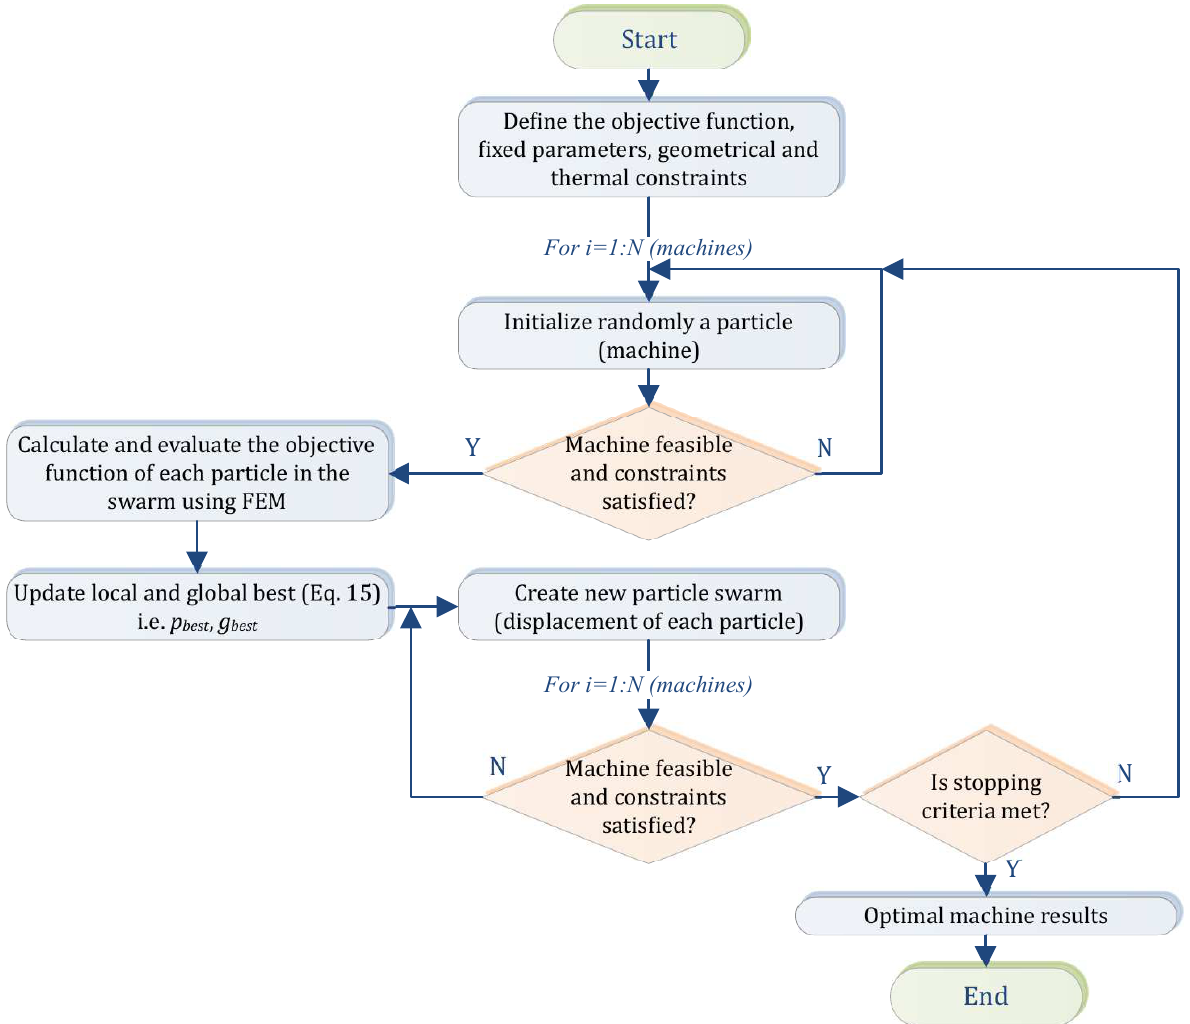
Figure 7. PSO algorithm flowchart (see also Appendix